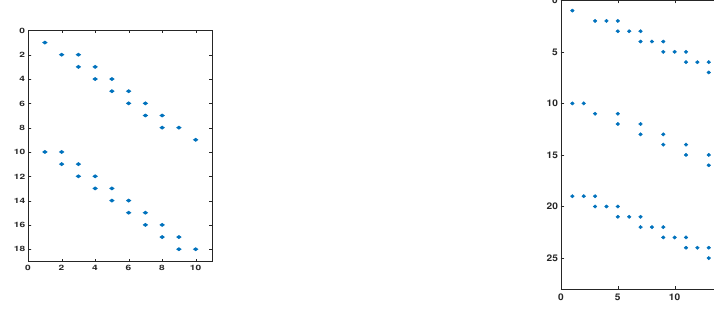
Figure 1. Sparsity structure of the matrix A with N = 8, R = 1 ( left ) and with N = 8, R = 2 ( right